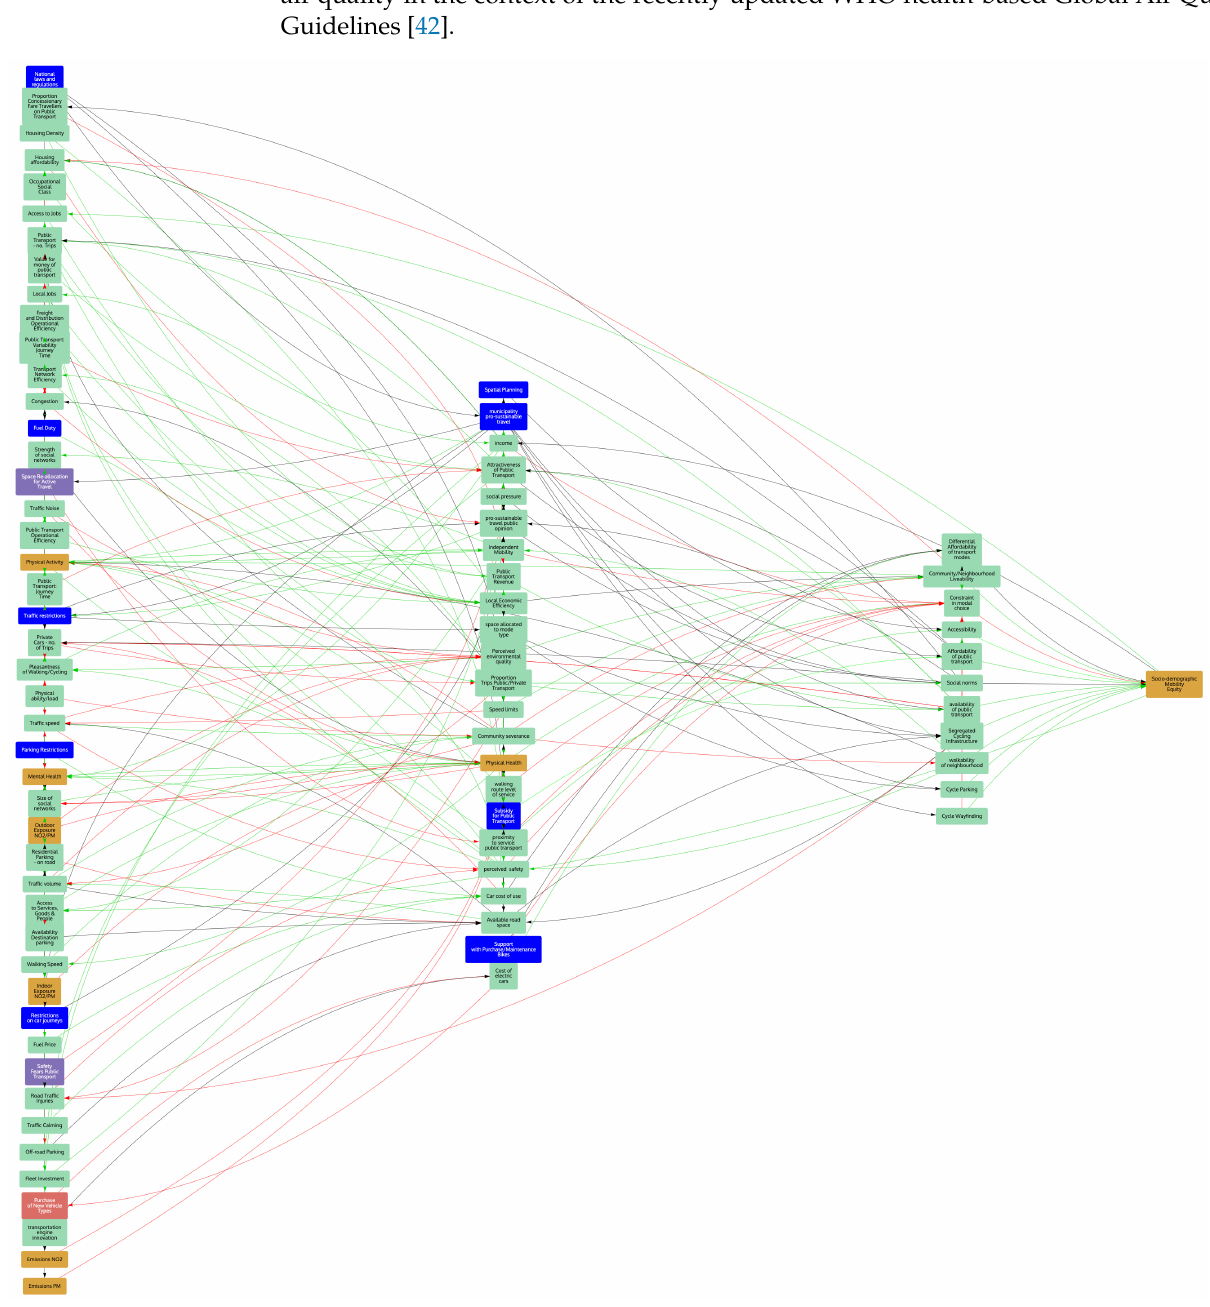
Figure 8. Socio-demographic mobility equity: upstream 3